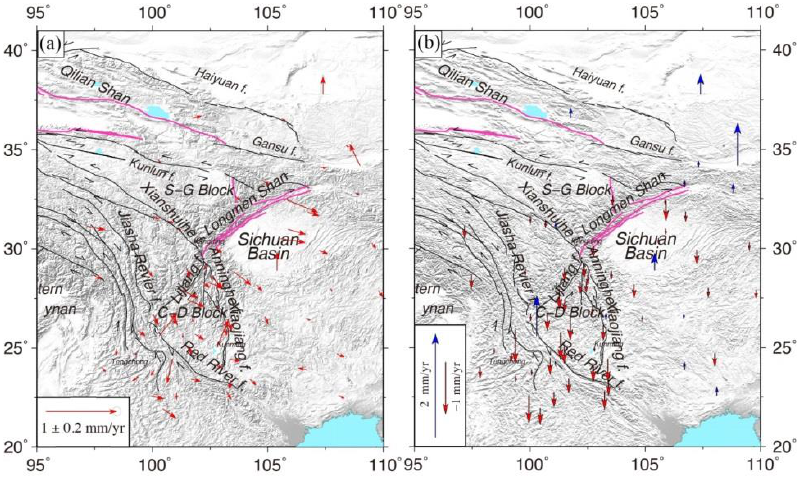
Figure 13. Residual effect on the three-dimensional GPS velocity in the ETP. ( a ) Residual of the difference between the unfiltered and filtered CMCs of the horizontal GPS velocity with respect to the ITRF 2008 frame; ( b ) residual of the vertical velocity with respect to the ITRF 2008 frame.